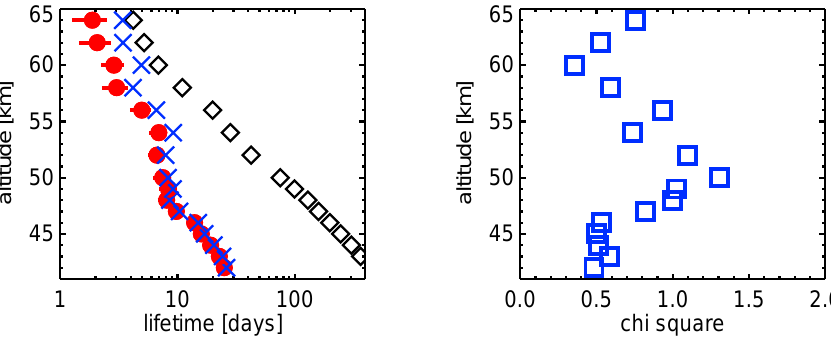
Fig. 2. Left: altitude-dependent lifetimes of NO x after the SPE at 30 October between 50 ◦ S and 90 ◦ S. The lifetimes τ as calculated from MIPAS measurements are displayed in red. The red error bars show the 1- σ range of the value. The photochemical lifetimes τ phot are displayed in black diamonds. The resulting dynamic lifetimes τ dyn are displayed in blue crosses. Right: altitude-dependent χ 2 values between measurement and fit of the exponential function according to the figures left.